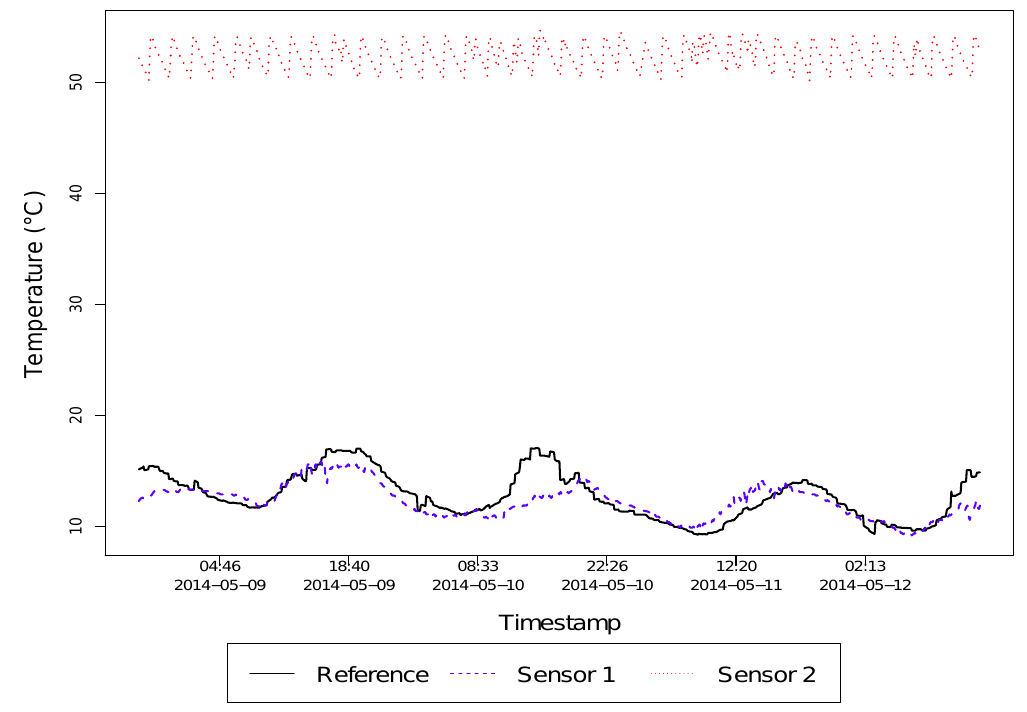
Figure 3. Different sensor readings for the “temperature” tag, but with different meanings (Dataset